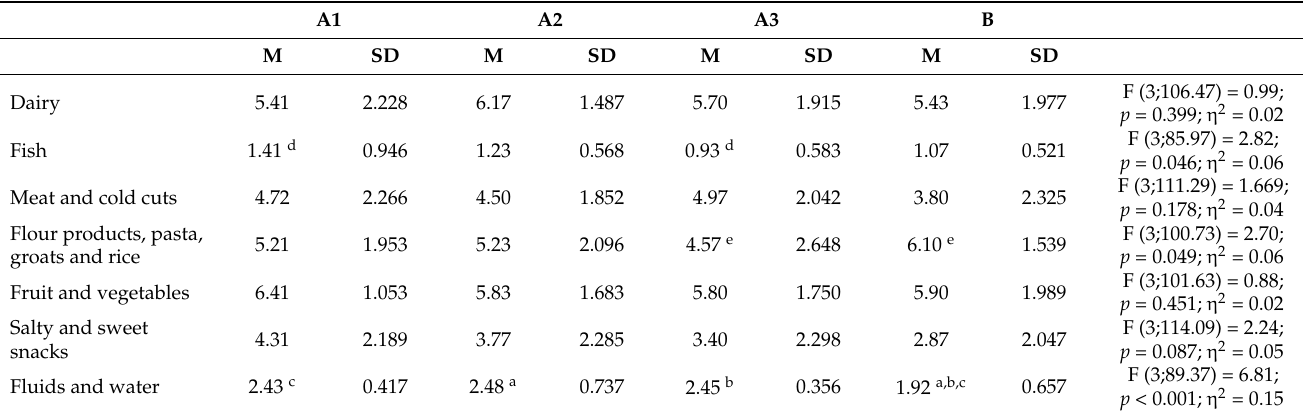
Table 3. Frequency of consuming specific foods during a week and volume of fluids drank a day in groups A1, A2, A3 and B.